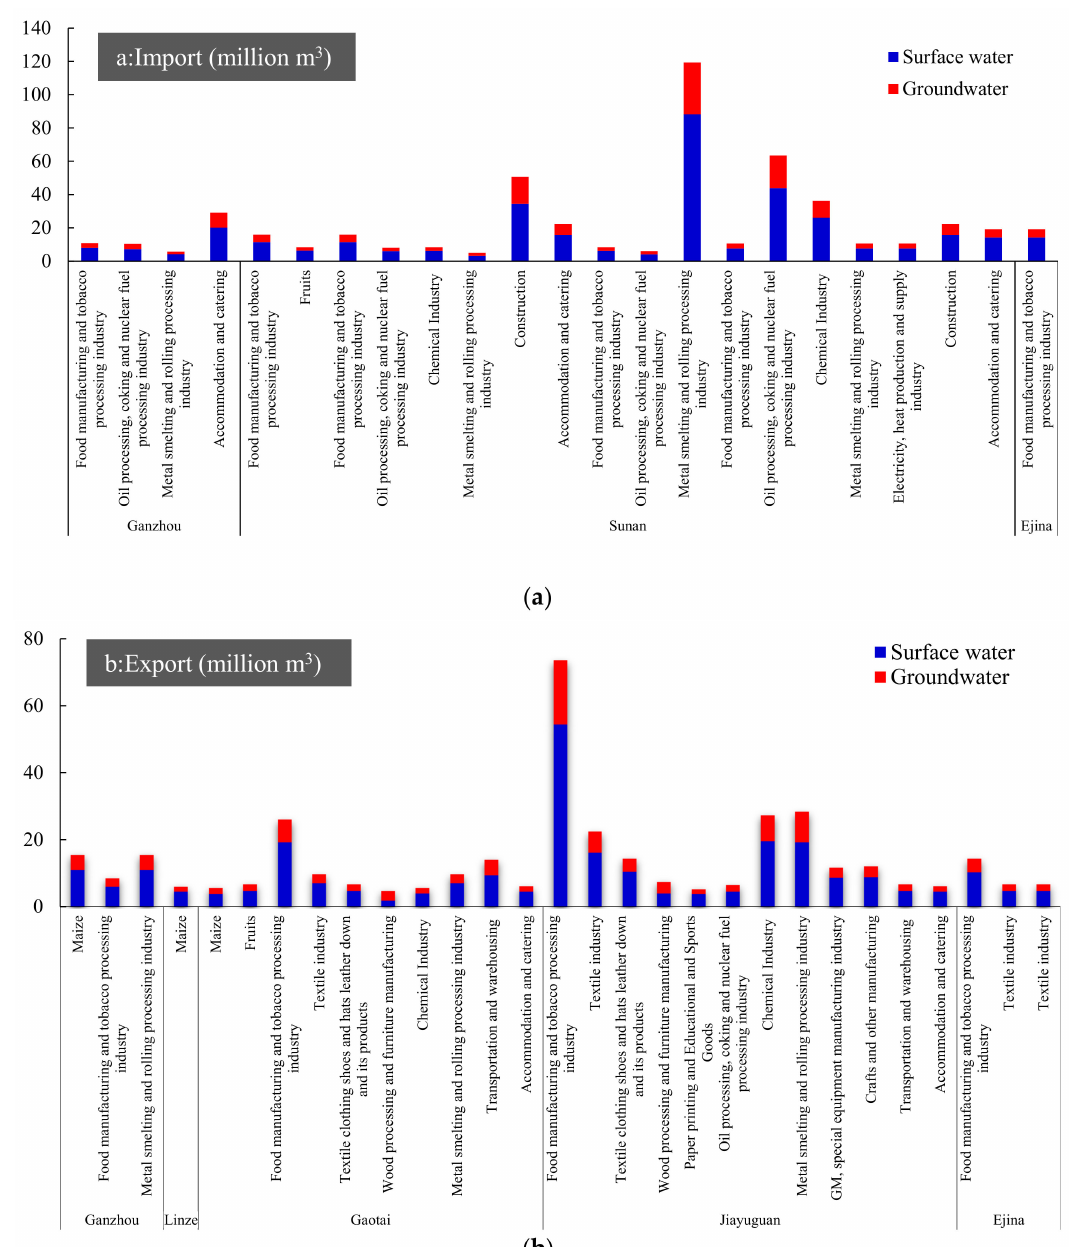
Figure 4. The inter-basin virtual water flows at the county level by sector in the Heihe River Basin. ( a ) virtual water import; ( b ) virtual water